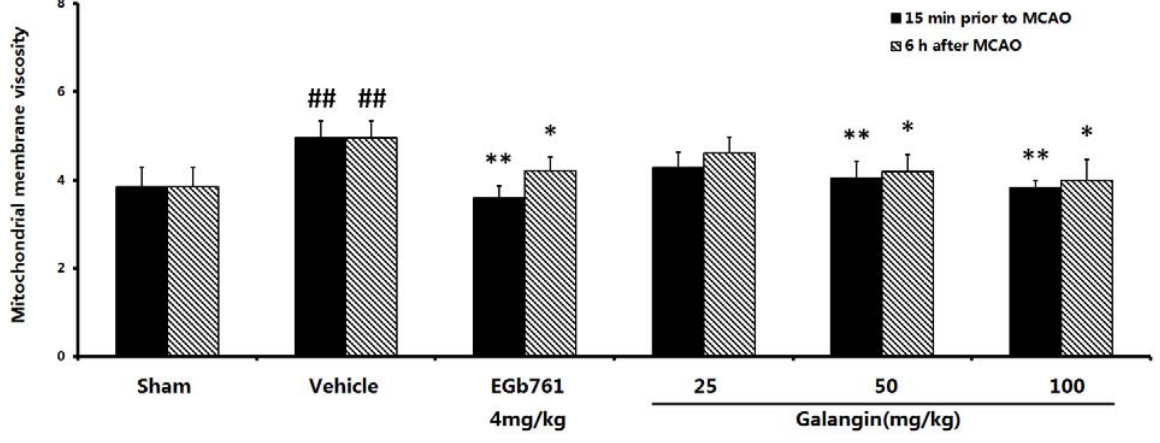
Figure 5. Effects of galangin on mitochondrial membrane viscosity caused by MCAO. EGb761 and galangin were both administered by i.g. 15 min prior to MCAO and 6 h after MCAO. The values were expressed as the mean ± SD (n = 10), and the values were analyzed by one-way ANOVA. ## p < 0.01, # p < 0.05 versus the sham group; ** p < 0.01,* p < 0.05 versus the vehicle